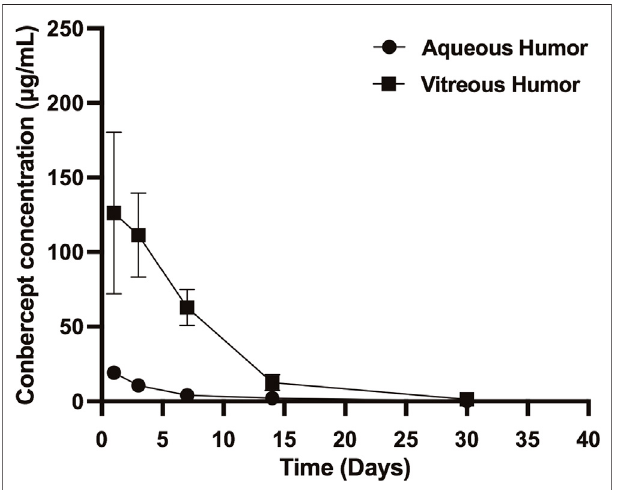
FIGURE 1 | Conbercept concentration in the vitreous humor and aqueous humor after intravitreal injection of 0.5 mg of conbercept. Samples were taken from the aqueous and vitreous of the injected eye.